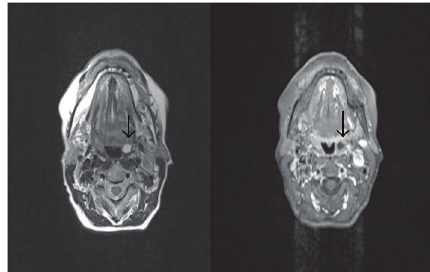
Figure 1: A cystic mass (black arrow) hypointense on T1 images and hyperintense on T2 was observed inside the right tonsil at magnetic resonance imaging (MRI).